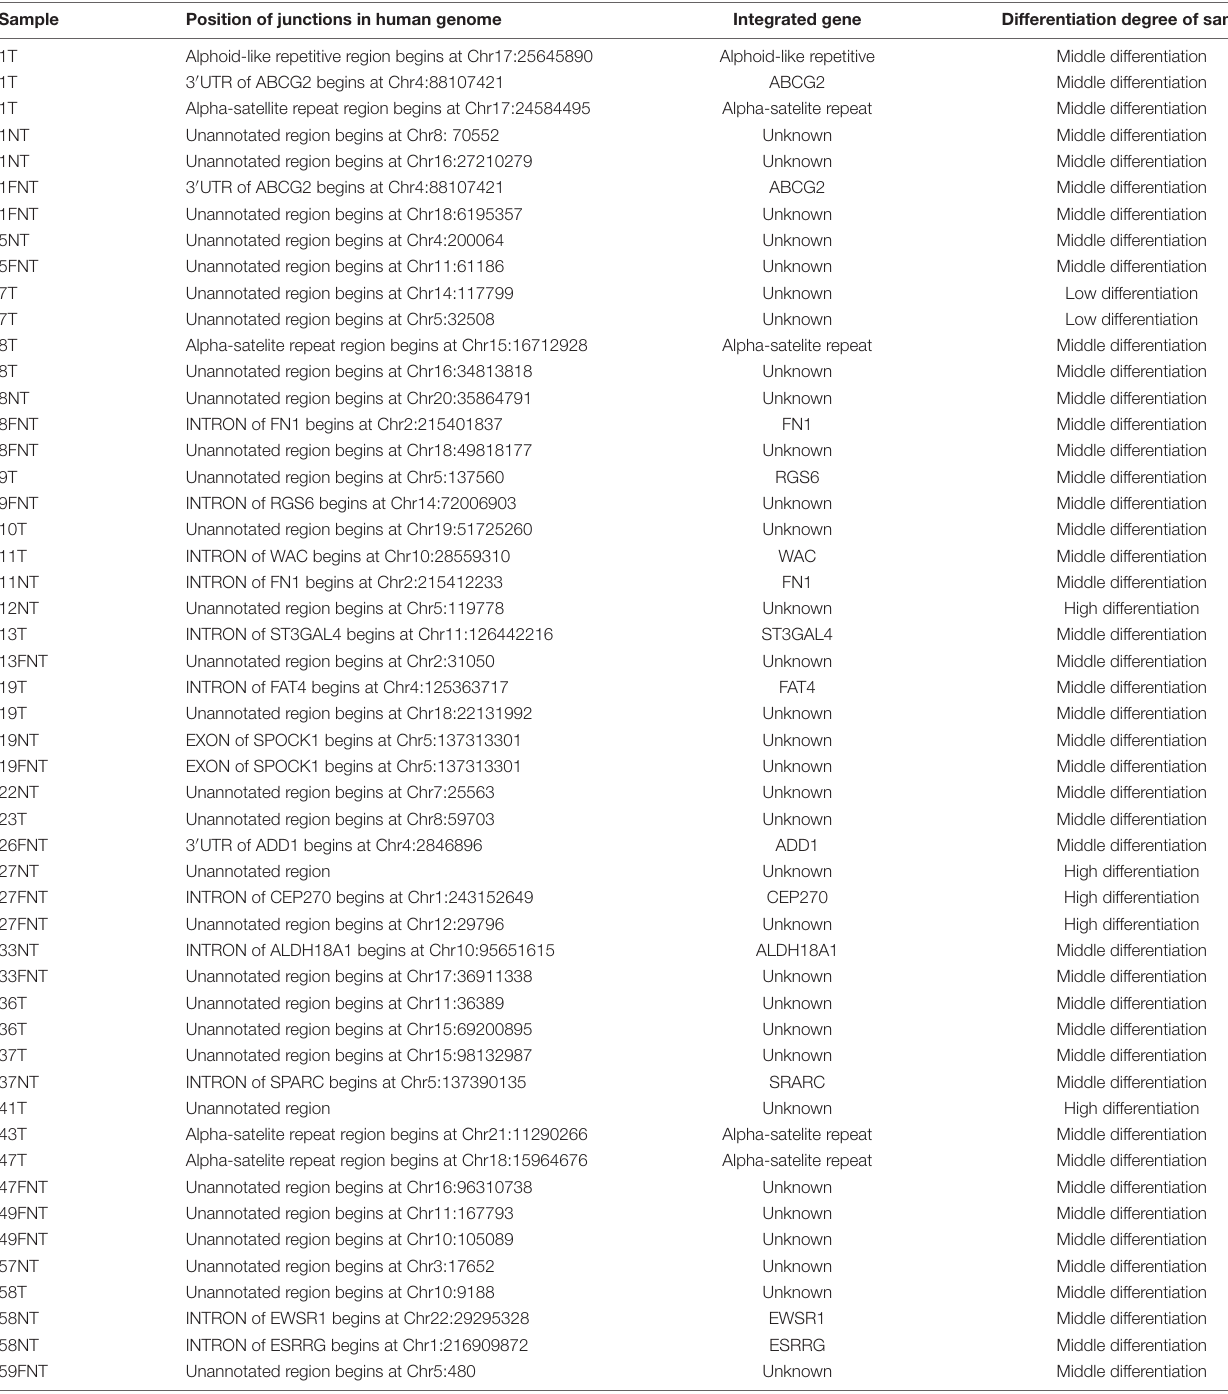
TABLE 3 | The description of HBV RT integration in tumor